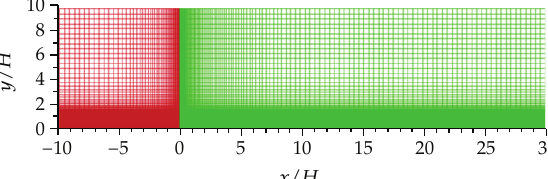
Figure 3: Grid system used in this study (cid:7) green grids showing downstream of the fence; red grids showing upstream of the fence (cid:8) .